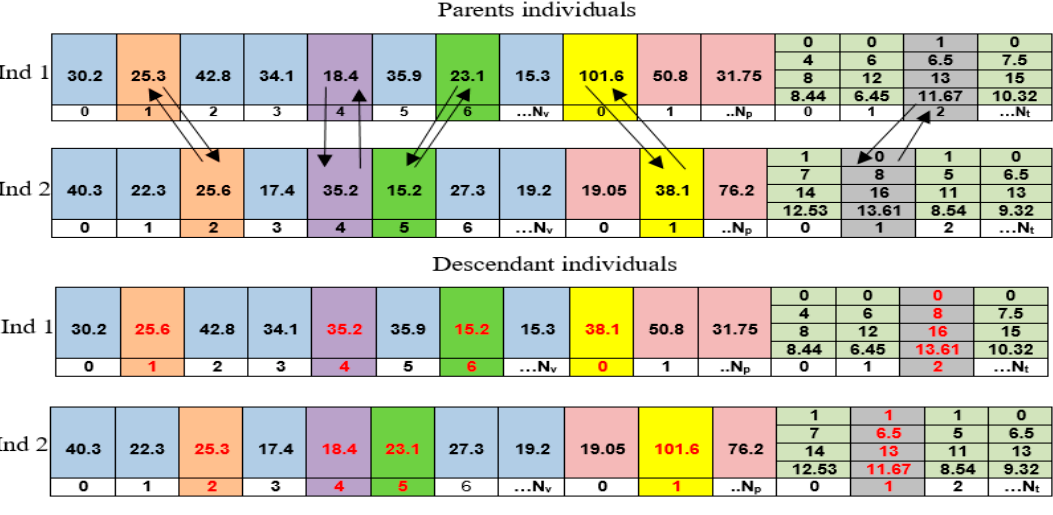
Figure 6. Crossover operator procedure (GIBI).